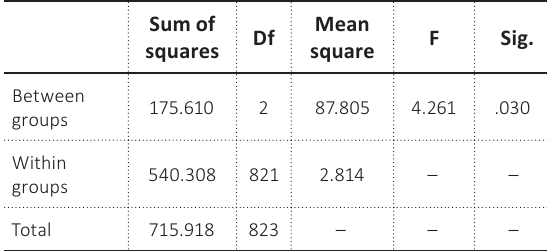
Source: Field survey,